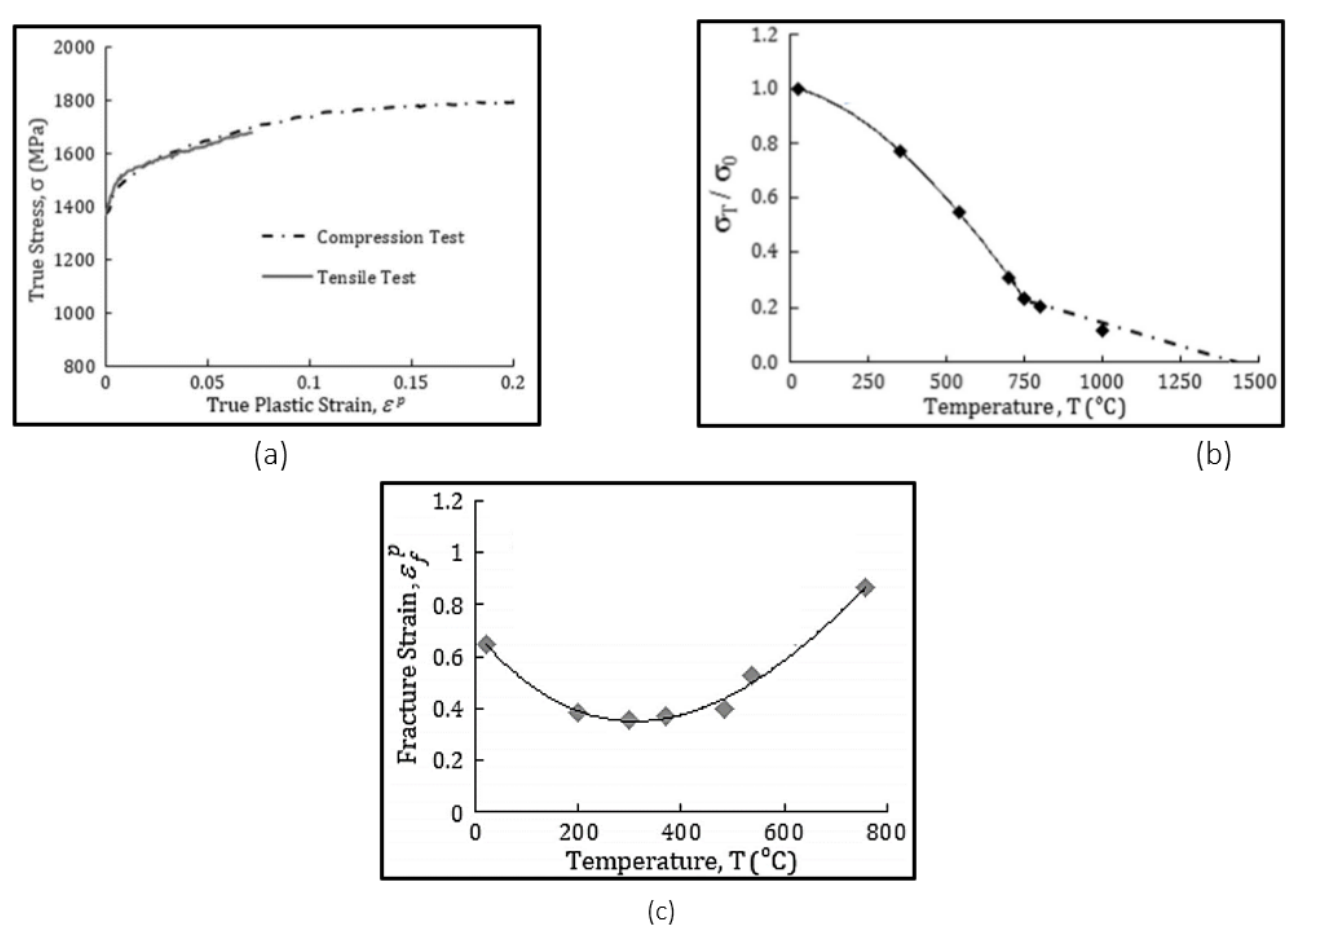
Figure 2. For material AISI 630 stainless steel, ( a ) true stress strain curve, ( b ) thermal softening curve, ( c ) fracture strain curve (adopted from [21]).